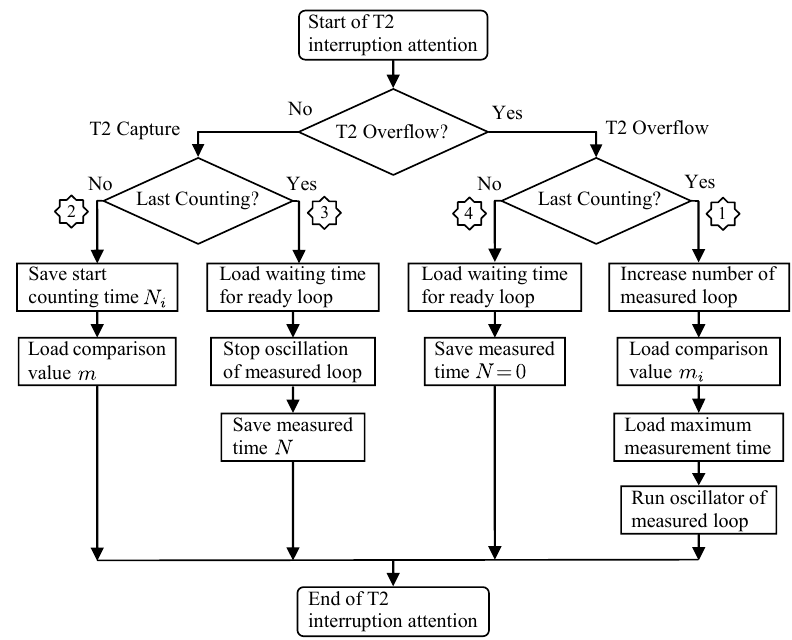
Figure 10. Flowchart of attention at T2 interruption.